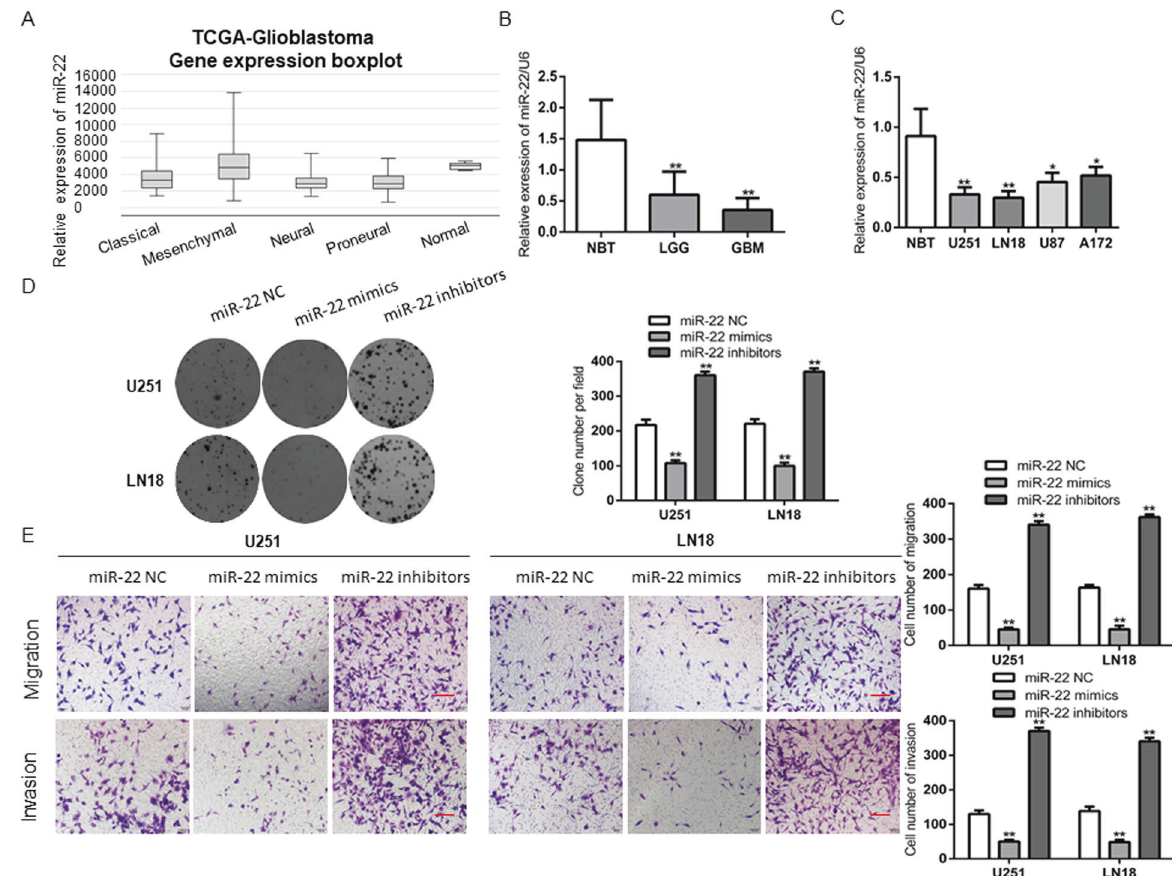
Fig. 5 MiR-22 was downregulated in GBM. A , B TCGA date indicated that miR-22 was lowly expressed in GBM and was inversely correlated with pathological grades of glioma. ** P < 0.01 vs. NBTs group. C RT-QPCR analysis the expression levels of miR-22 in normal human astrocyte (HA) and four GBM cell lines (U251, LN18, U87 and A172). * P < 0.05, ** P < 0.01 vs. HA group. D , E CCK-8 assay and Transwell assay was performed to determine the proliferation, migration and invasion effect of miR-22 mimics and miR-22 inhibitors after transfected with U251 and LN18 cells (scale bar: 200 μ m for Transwell assay). ** P < 0.01 vs. miR-22